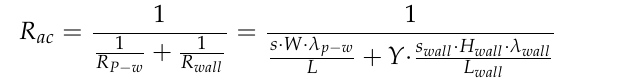
Table 2. Deviations of fluid properties of air in relation to lowest investigated condition ( T = 273.15 K or p = 100 kPa (rel)). Thermal Dynamic Specific Heat Capacity Conductivity Viscosity (%) (%) Isobaric (%) Isochoric (%) (%) (%) Maximum deviation from temperature of T = 273.15 K Maximum deviation from pressure of p = 100 kPa